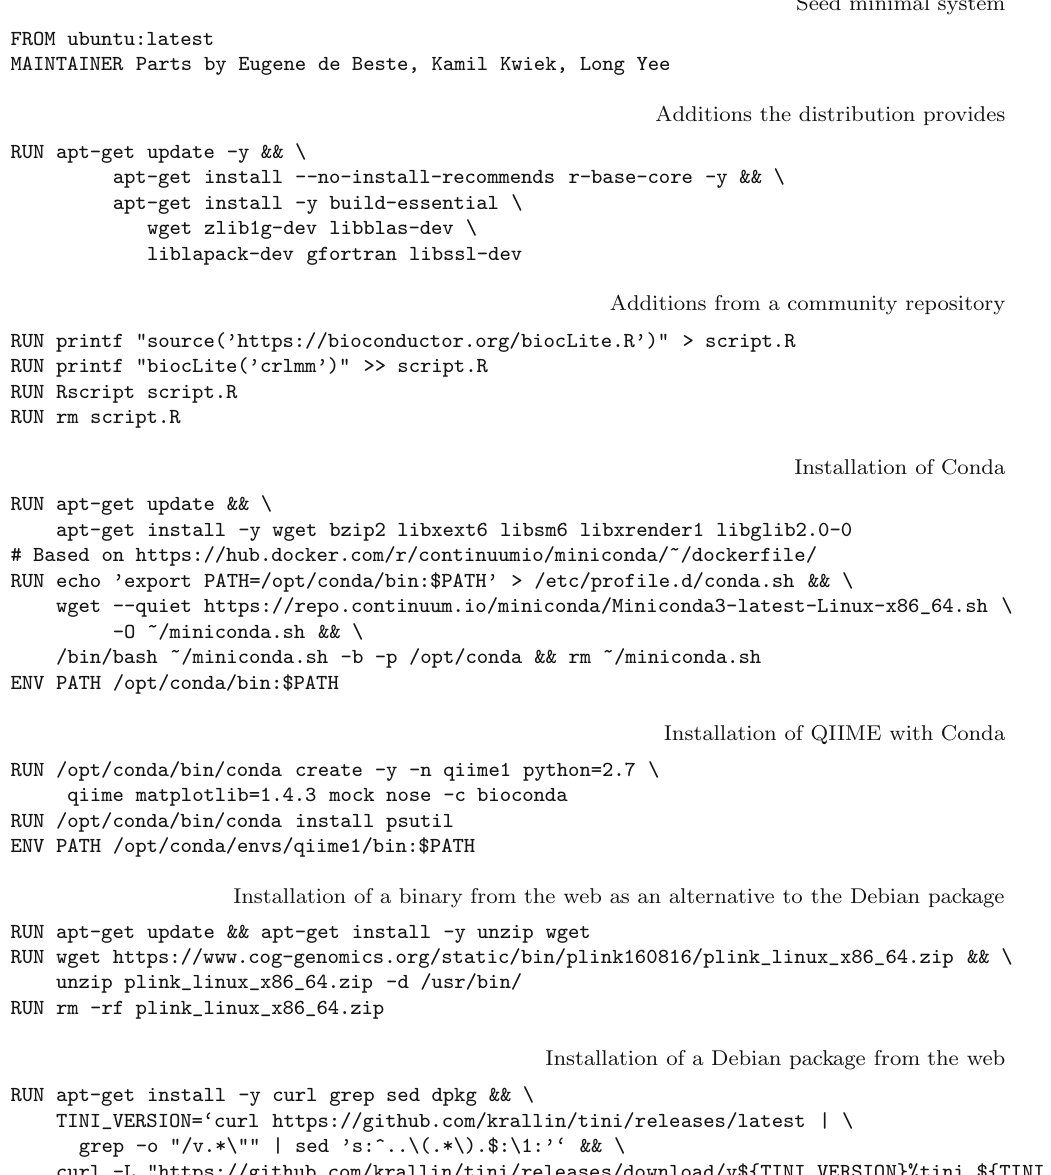
Table 2 Example for the configuration file for a Docker container. It combines an Ubuntu basic image with packages retrieved from Biocon- ductor, Bioconda or a static web address. (https://github.com/h3abionet, https://hub.docker.com/r/continuumio/miniconda/)